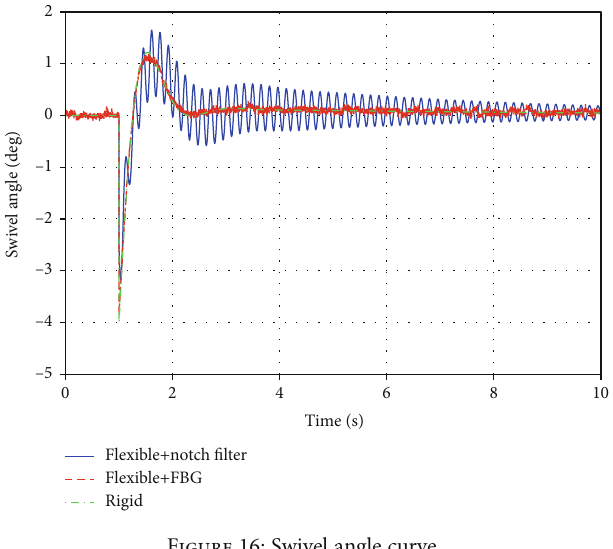
Figure 16: Swivel angle